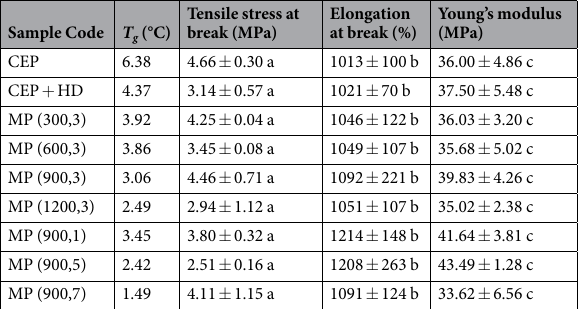
Table 1. The glass-transition temperatures and mechanical properties of the isolated films. Means with the same letter are not significantly different at p ≤ 0.05 level.